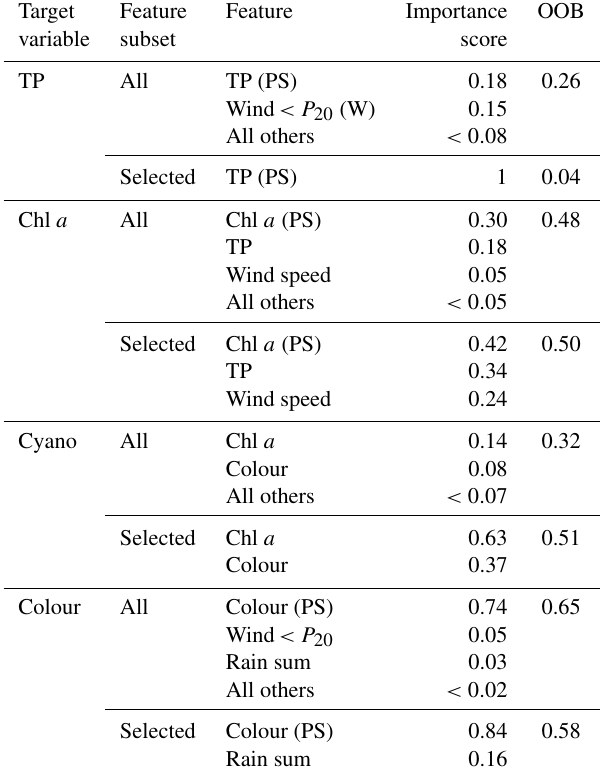
Table 4. Summary of the feature importance analysis for each de- pendent variable. The out-of-bag (OOB) score gives the overall per- formance of the random forest regressor model, whilst importance scores rank the importance of the features. Results are shown us- ing all available features (All) and for the feature subset selected for BN development (Selected). See Table 1 for a description of the features.